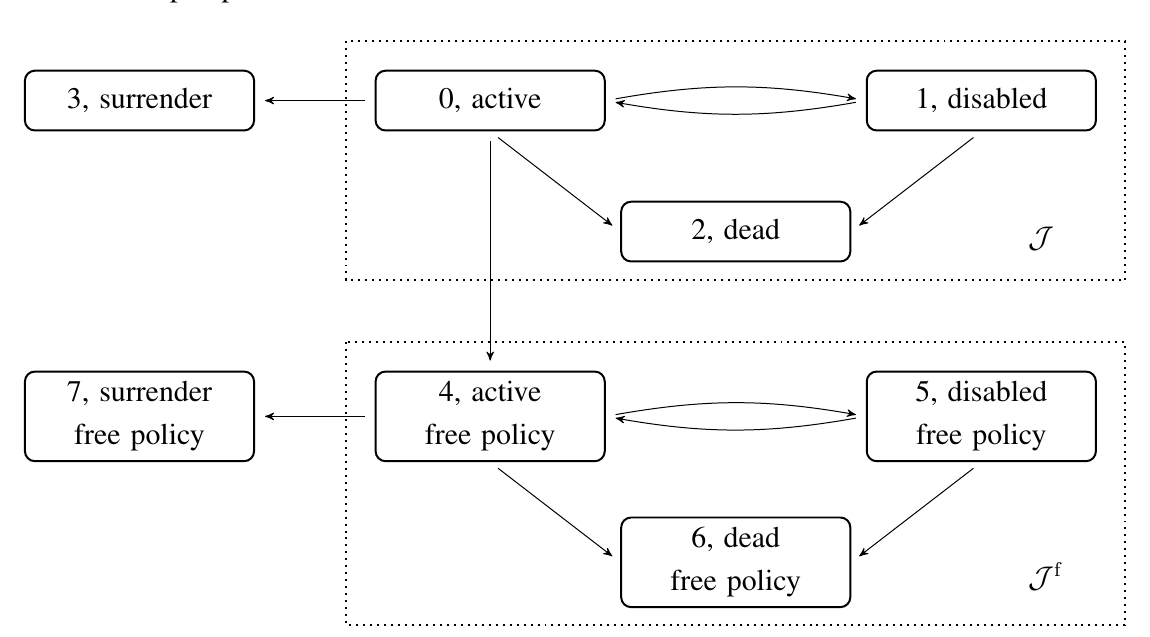
Figure 4. The eight-state Markov model, with disability, surrender and free